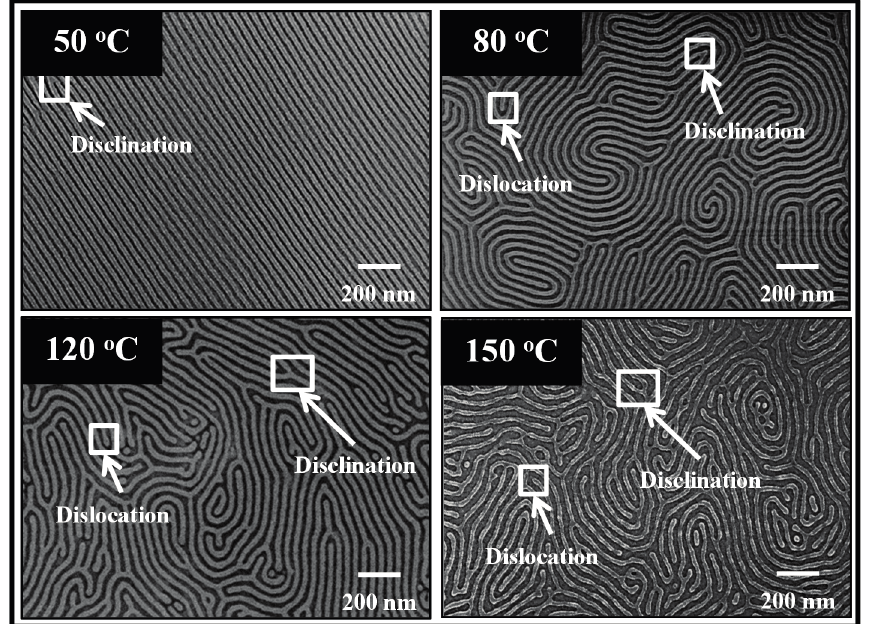
Figure 3. Top-down SEM images of the PS- b -PDMS pattern formed via microwave annealing in the presence of toluene for 30 s at different target temperatures as labelled on the